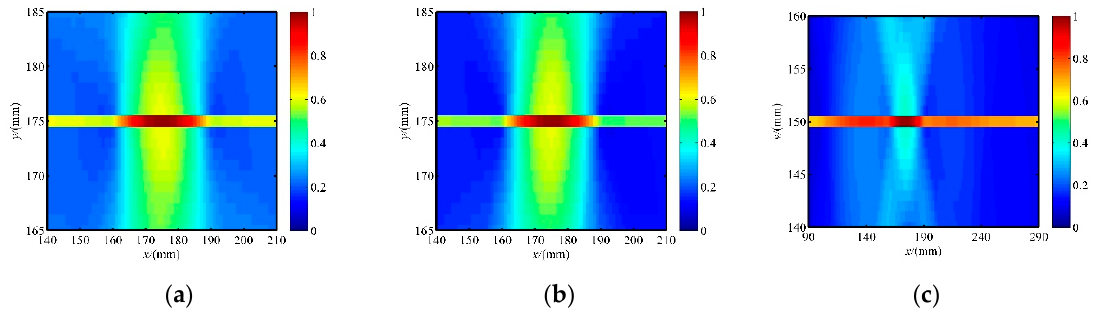
Figure 10. The improved RAPID algorithm with the predicted crack orientation: ( a ) image with a circular array, ( b ) image with a square array, and ( c ) image with a parallel linear array.